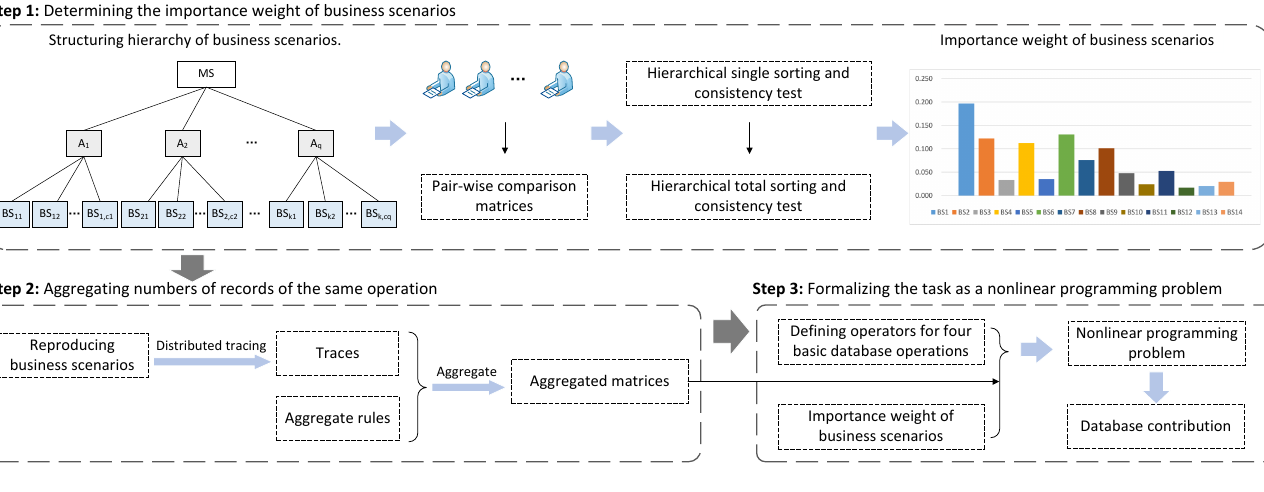
Figure 2. An example of a general microservice system. The main practical influence of the calculated database contribution is to provide information for runtime deployment optimization.